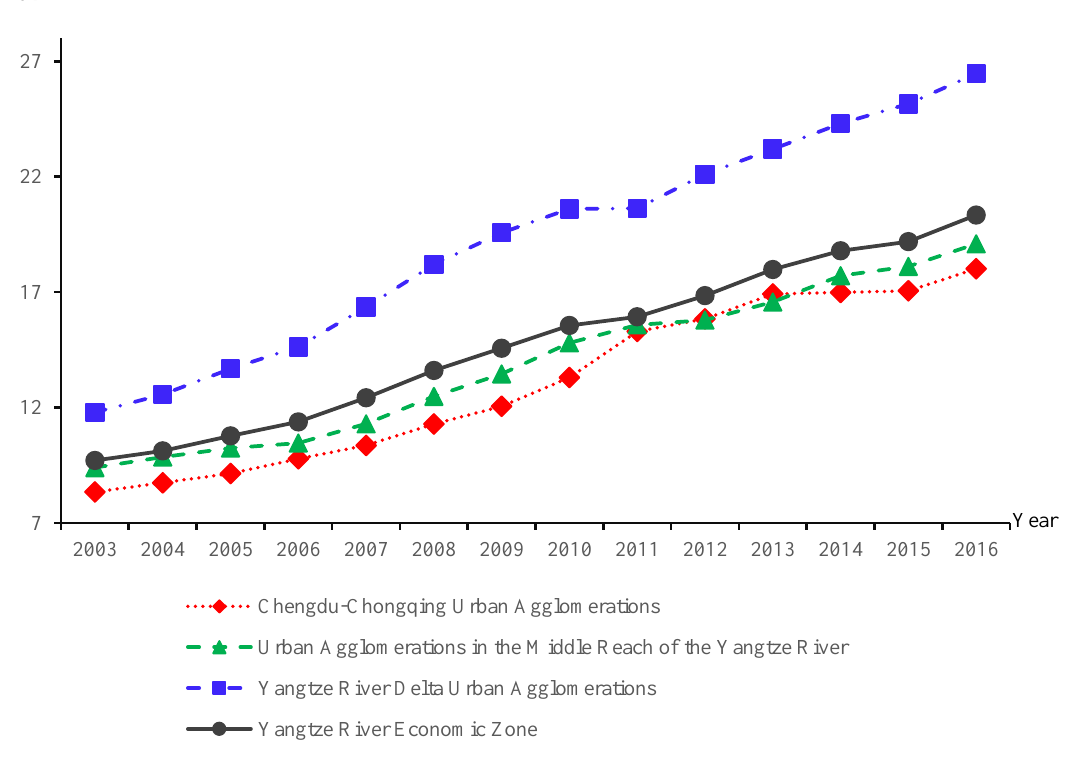
Figure 4. The GD of the YREB and comparison between its three major urban agglomerations.